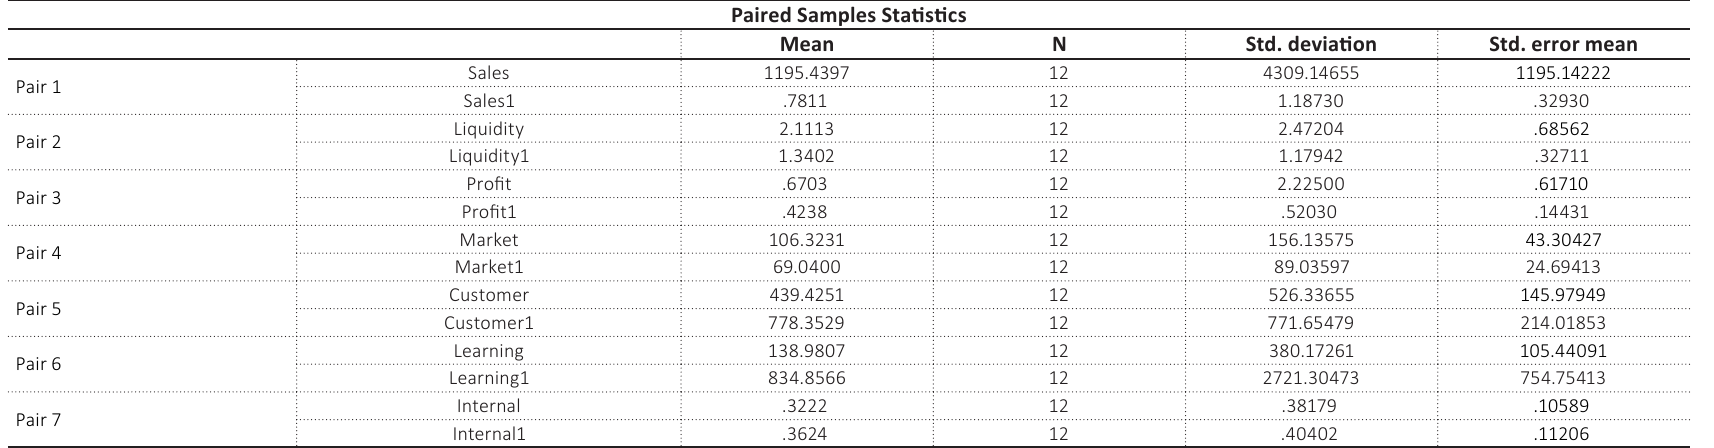
Table C1. Statistical analysis for BSC